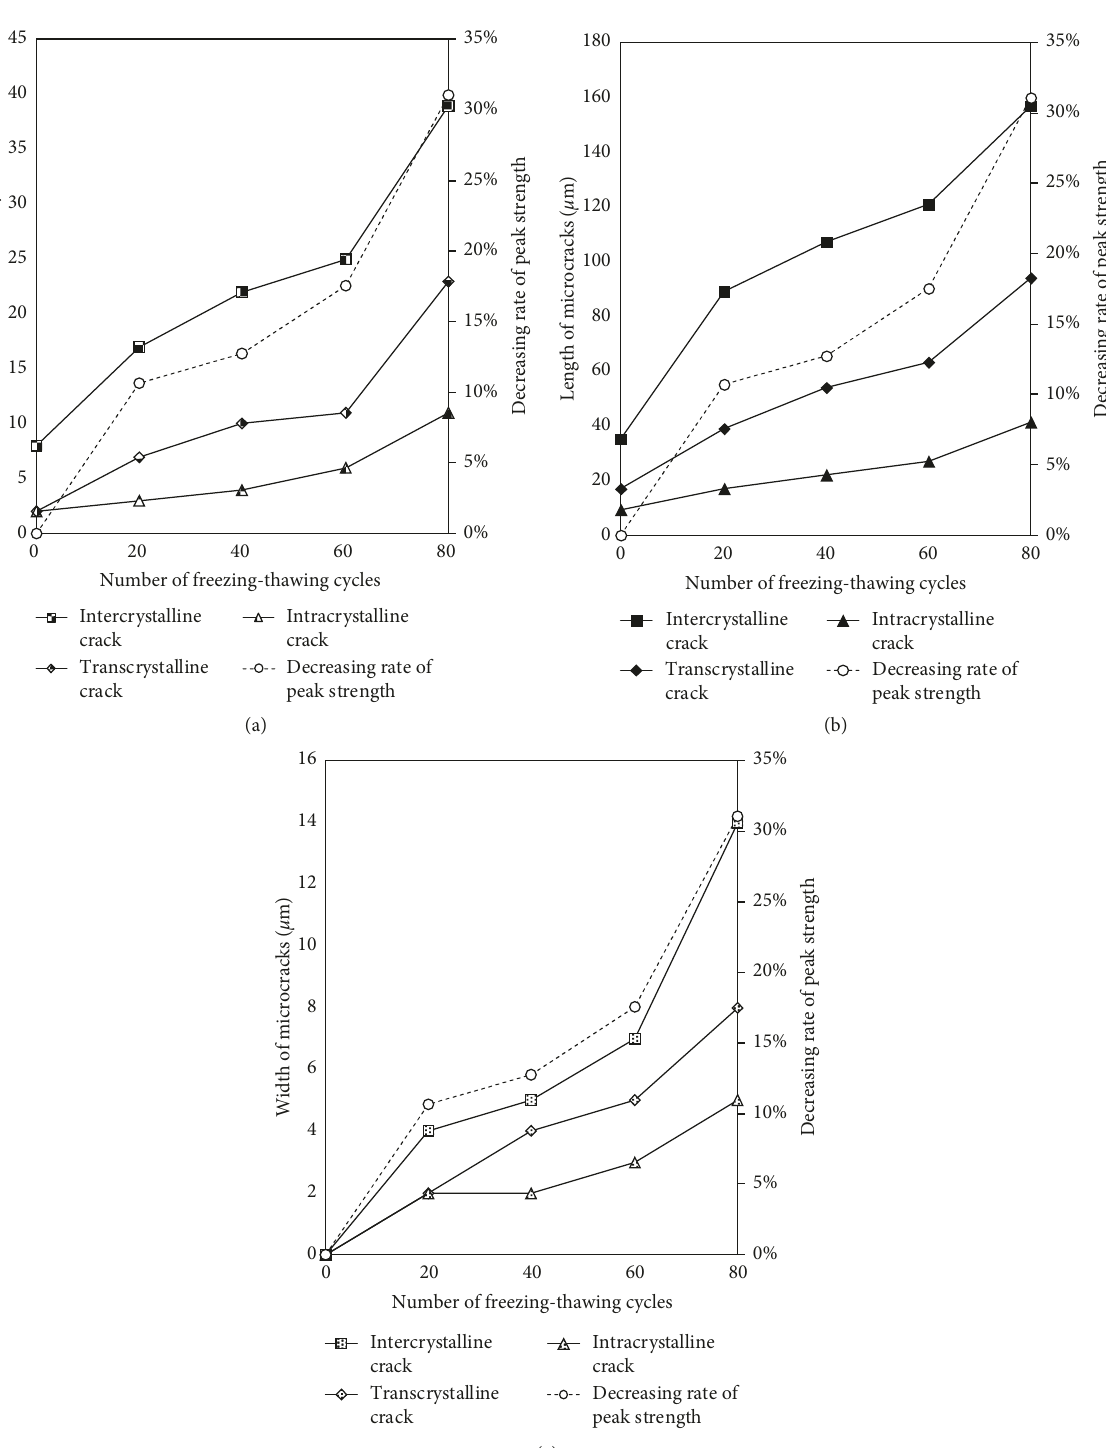
Figure 9: The (a) total number, (b) median length, and (c) median width of the microcracks under freezing-thawing